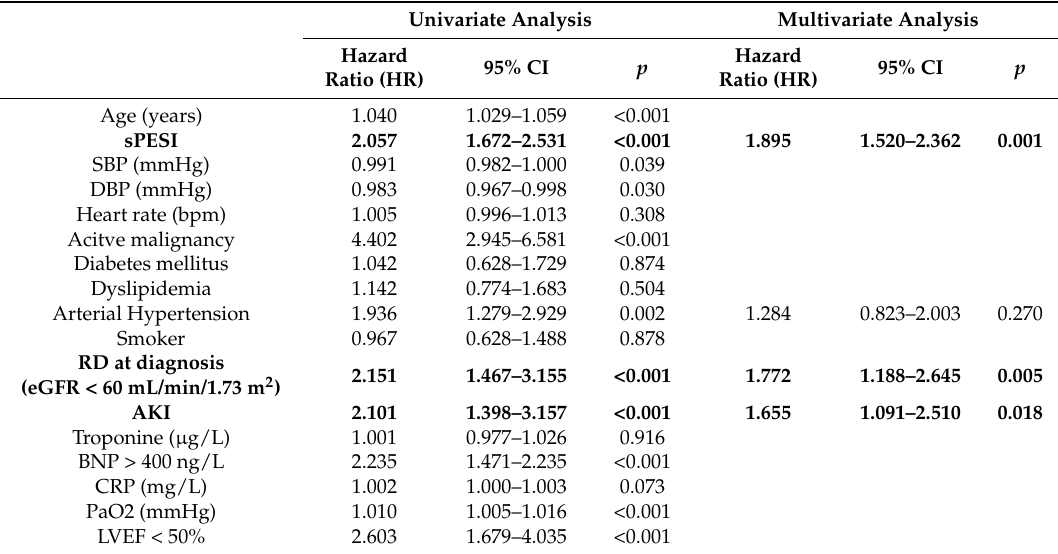
Table 4. Univariate and multivariate analyses for the prediction of overall mortality. Univariate Analysis Multivariate